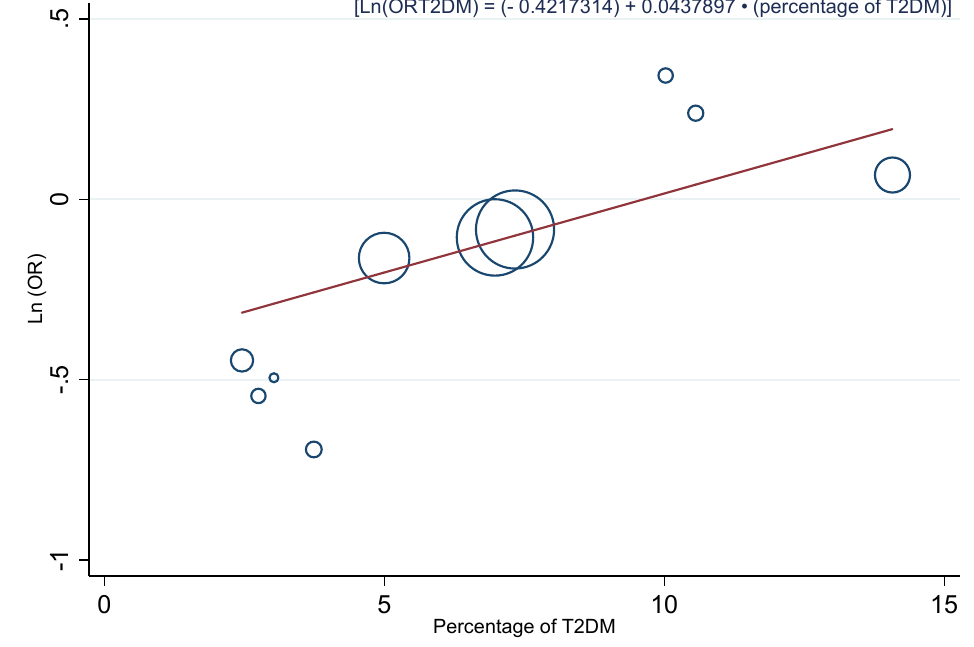
Figure 6. Bubble plot with a fitted meta-regression line of the relationship between the Ln(OR) and the percentage of T2DM. Circles are sized according to the precision of each estimate (the inverse of its within-study variance).